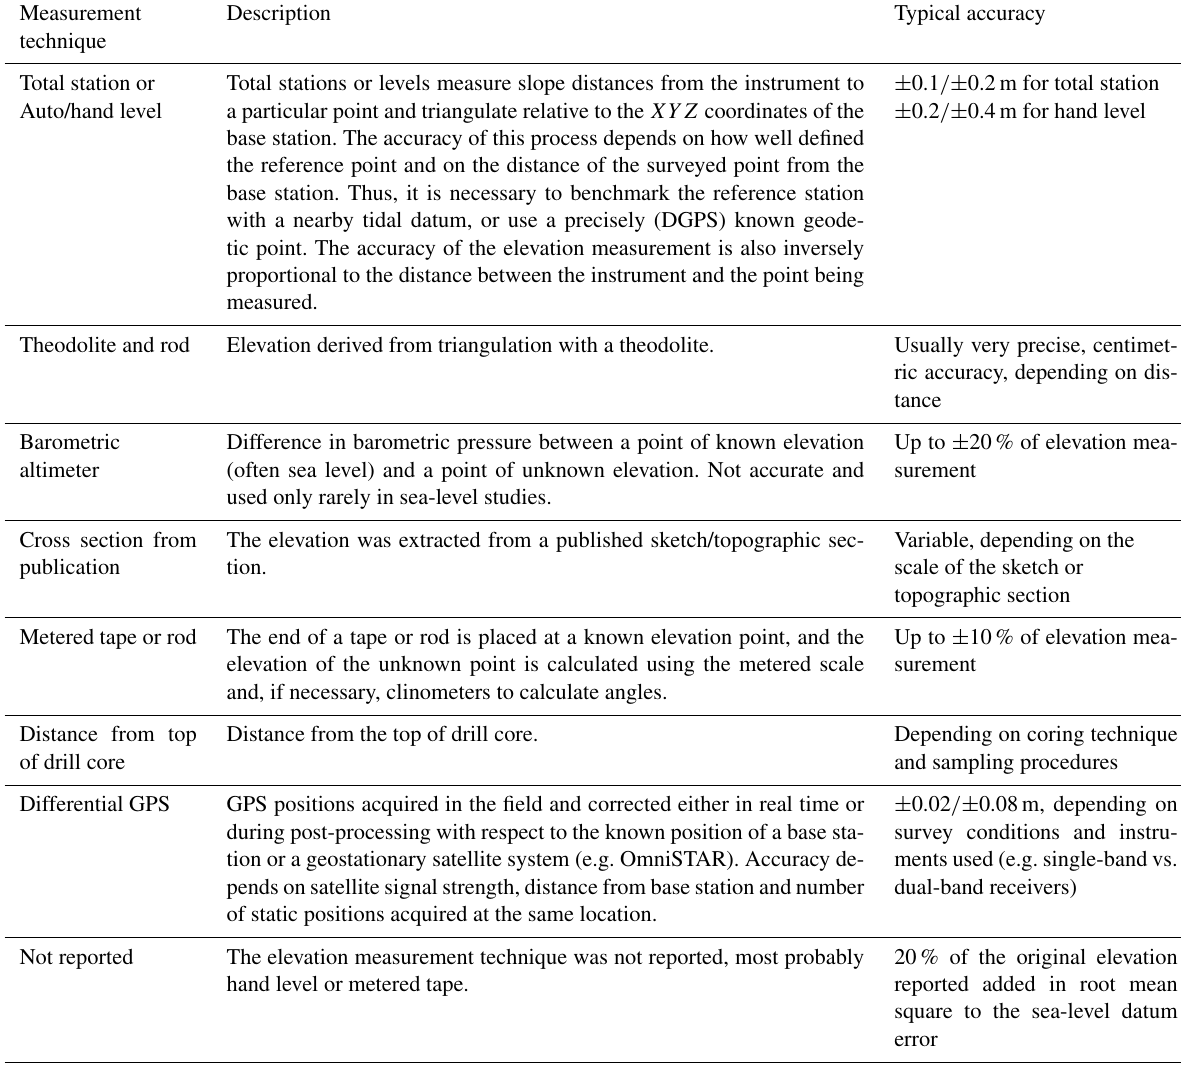
Table 3. Measurement techniques used to establish the elevation of MIS 5e shorelines in the tropical Pacific